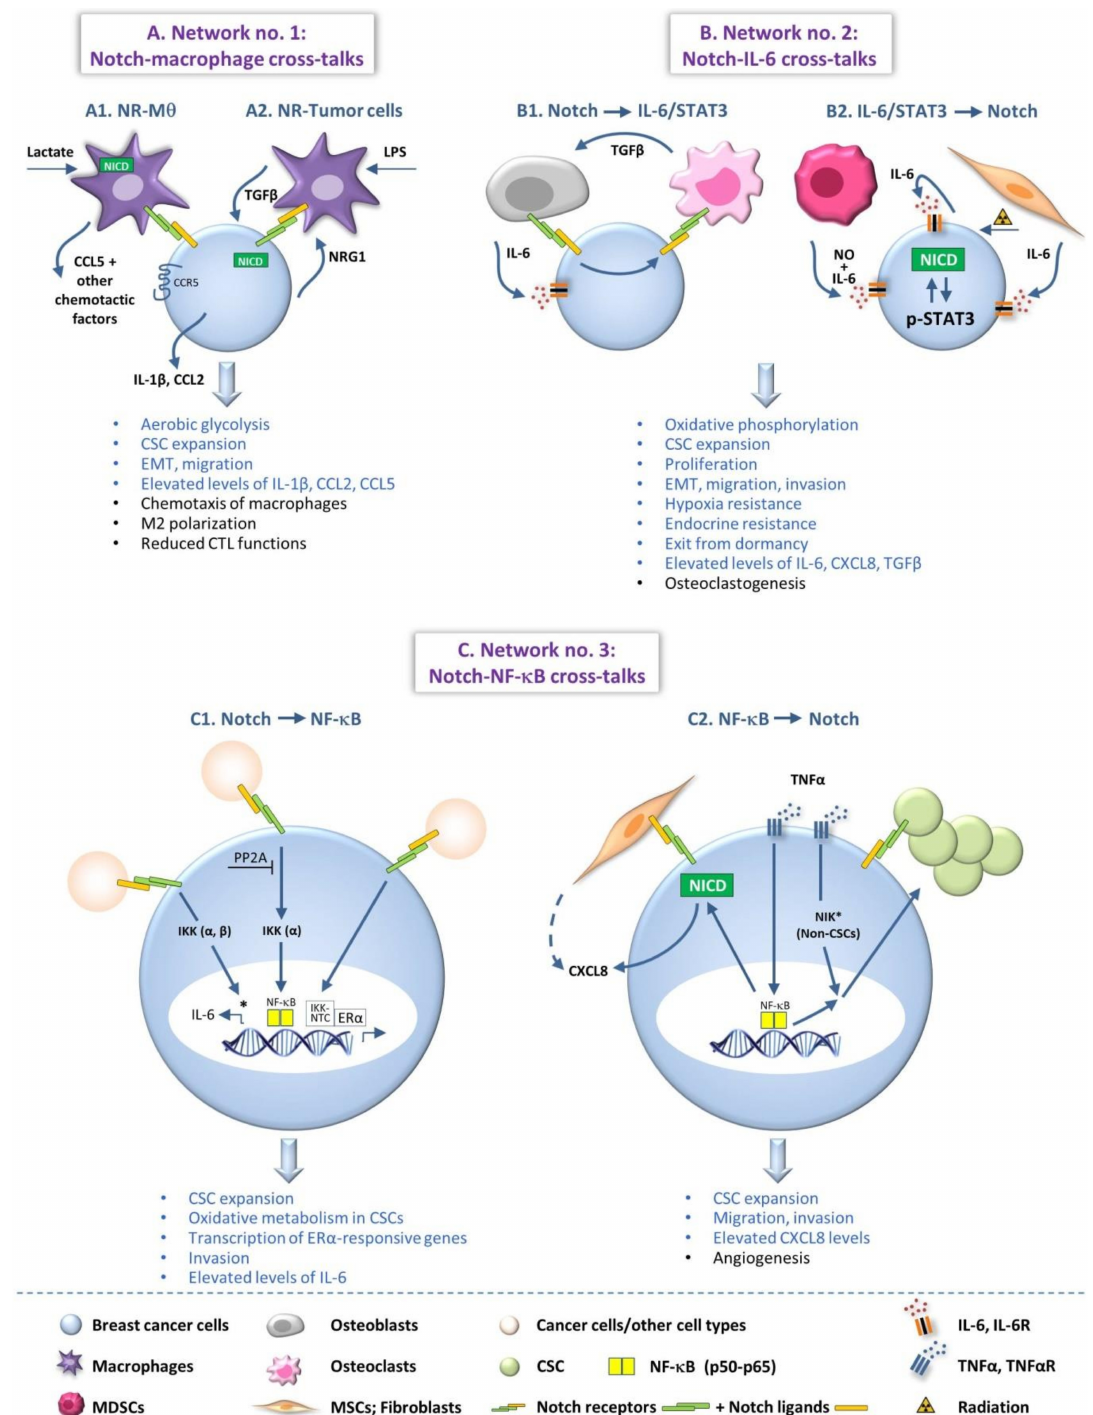
Figure 1. Notch-inflammation networks that promote breast cancer progression. The Figure demonstrates three major networks that are established between members of the Notch pathway and inflammatory elements in BC. For the sake of simplicity, not all processes and not all mechanistic details that were described in the di ff erent studies are demonstrated in the Figure. When several processes that were identified in di ff erent publications are illustrated in the same cell / setting, there is no intention to imply that they take place simultaneously. In the text, the readers are referred to the relevant parts that are demonstrated in the Figure. Three Notch-inflammation networks are demonstrated in the Figure: ( A ) Network no. 1—Cross-talks between the Notch pathway and macrophages, as key